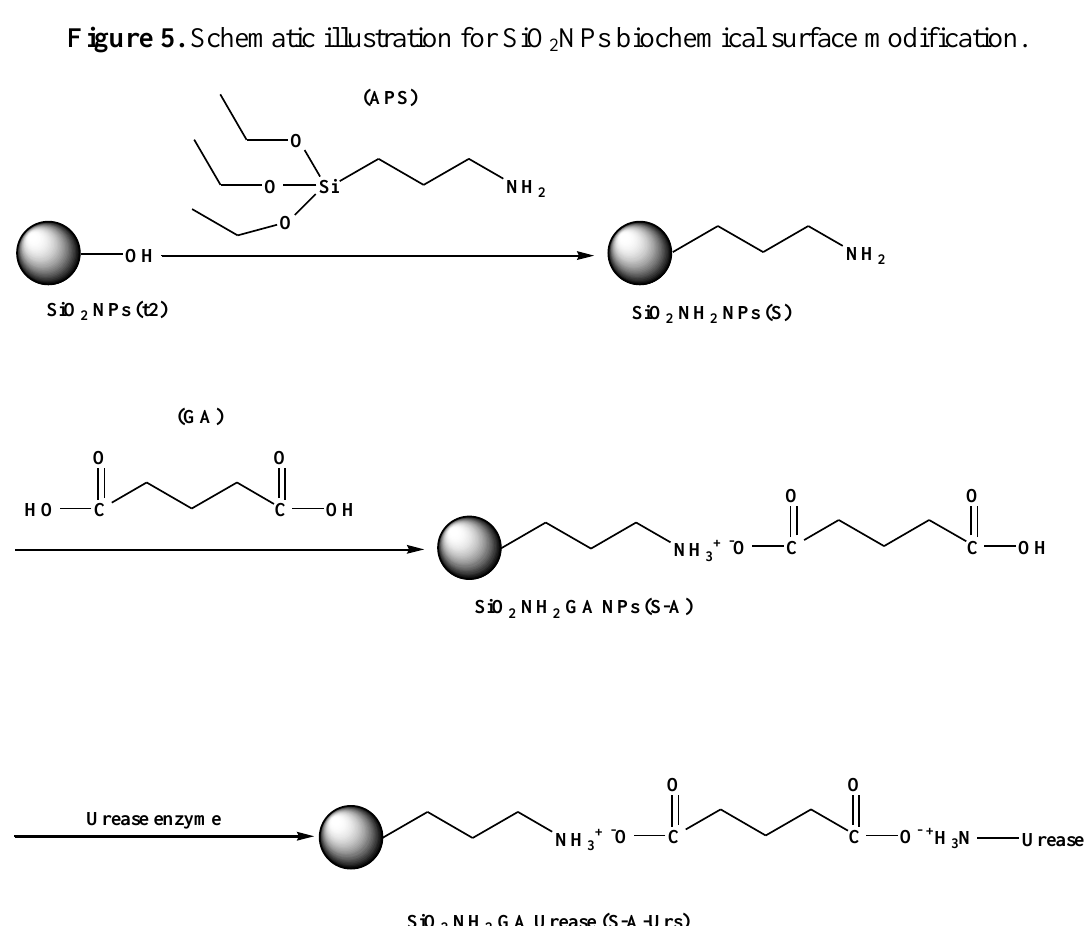
Figure 5. Schematic illustration for SiO